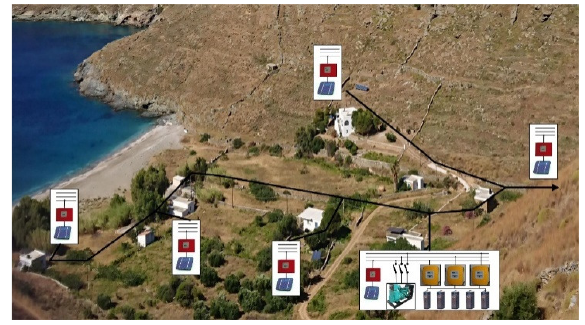
Fig. 8 Overview of the Kythnos microgrid [37]